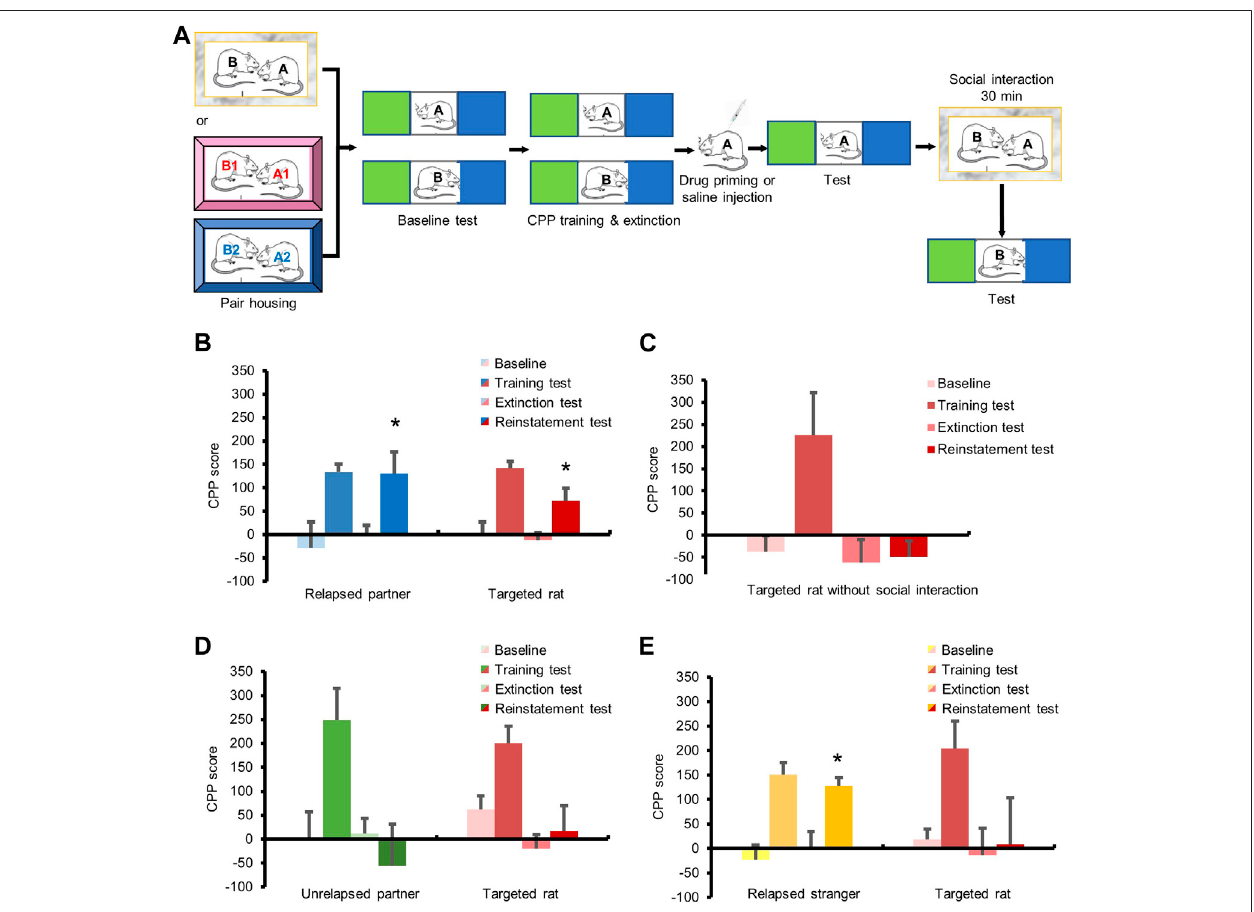
FIGURE 4 | Social interaction with relapsed partners triggered relapse in cocaine CPP model. (A) Experimental timeline. (B – E) All rats obtained cocaine CPP trainingandextinction. (B) Cocaineinjectiontriggeredrelapseofthepartners,andsocialinteractionwithrelapsedpartnerenhanceddrugseekingoftargetedrats. (C) No social interaction had no in fl uence on relapse of targeted rats. (D) Social interaction with unrelapsed partner had no effect on relapse of targeted rats. (E) Social interaction with relapsed stranger had no effect on relapse of targeted rats. (Data are shown as mean ± SEM. * p < 0.05, compared with extinction test. n (cid:1) 6 – 7).